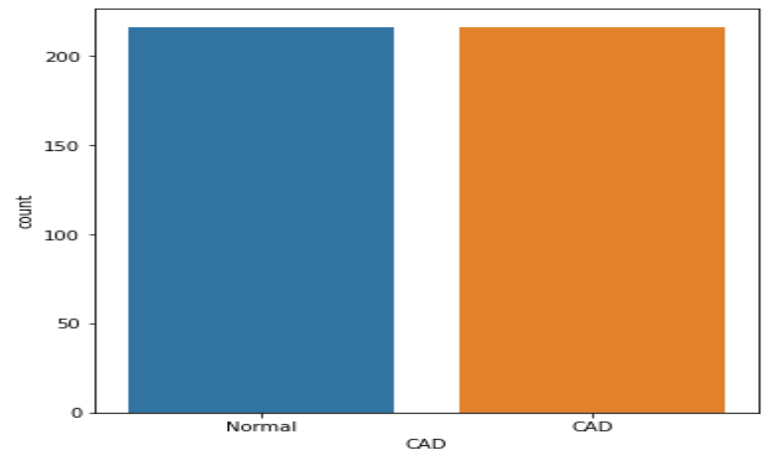
Figure 3. Data balancing using SMOTE.